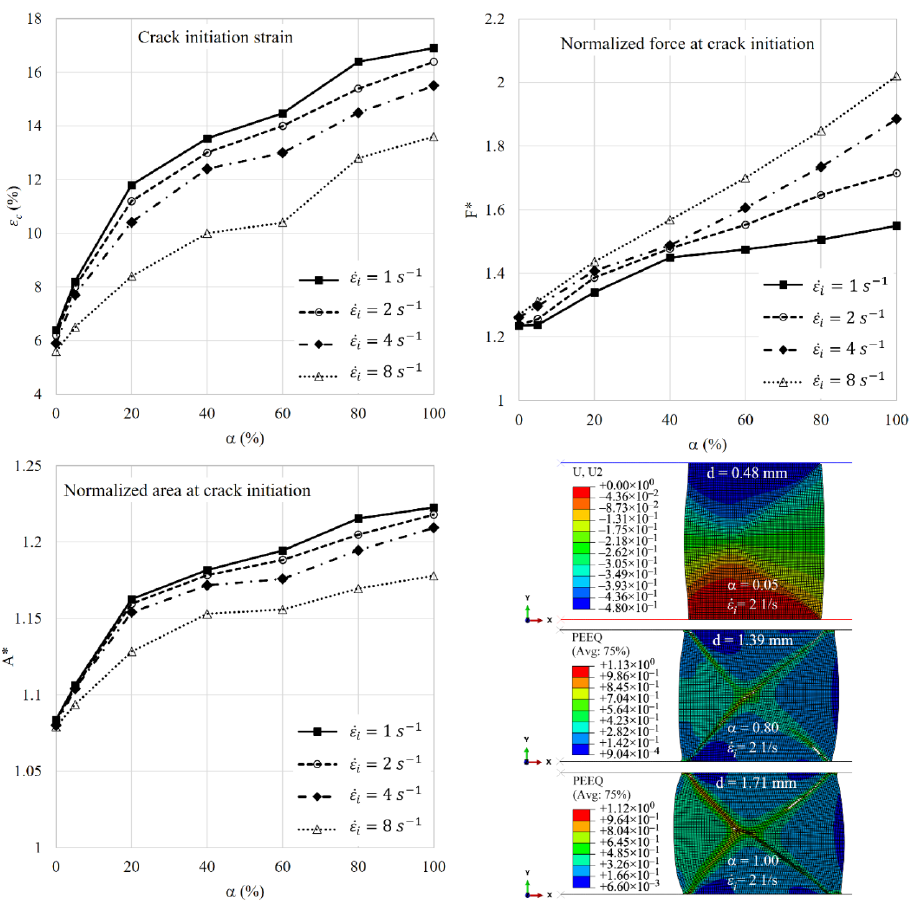
Figure 14. Effect of strain rate and cladding ratio on fracture parameters. The stroke of top platen, d , is shown at the top of the models.